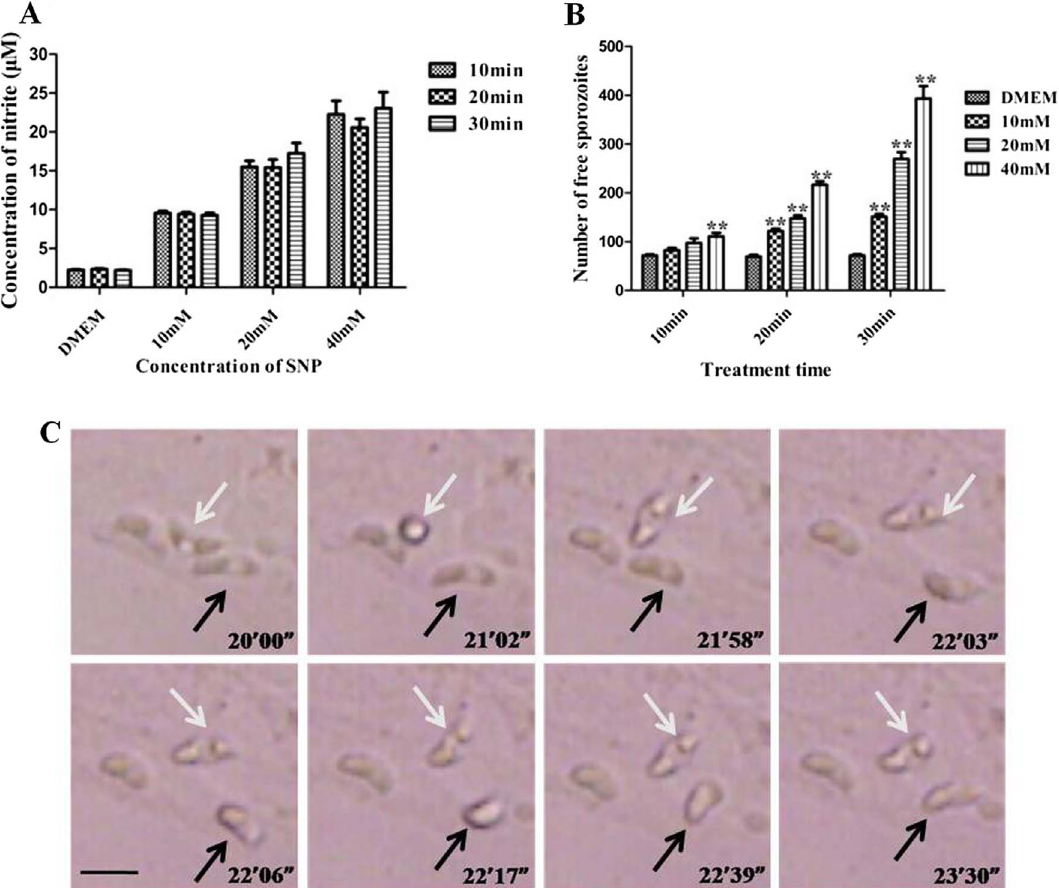
Figure 1. Exogenous nitrous oxide (NO) stimulates egress of Eimeria tenella sporozoites . (A) NO concentrations released by different doses of sodium nitroferricyanide (II) dihydrate (SNP) for a variety of durations. (B) Primary chicken kidney cells (PCKs) were infected with sporozoites and incubated with different concentrations of SNP for different times. The number of free sporozoites was analyzed by fl ow cytometry. Data are means ± standard error of the mean (SEM) of four replicates, representing three independent experiments. ** p < 0.01, comparing SNP with DMEM at the respective time point. (C) Video was captured from 20 to 25 min after SNP treatment; eight representative frames were selected and shown. Arrows indicate the egress process in two sporozoites. Bar: 20 l m.